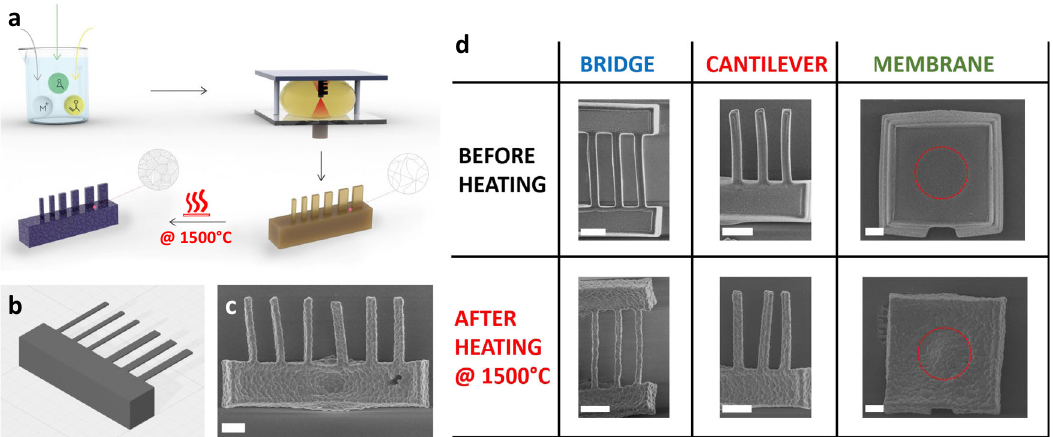
Fig. 2 Scheme of the fabrication process and images of the printed NEMS devices. a Scheme of the fabrication process starting from the precursor solution preparation, followed by TPP printing to photopolymerize locally the solution, structure washing, and fi nal heating step to remove organic content and achieve densi fi cation and crystallization. b CAD scheme and c SEM image of a chip composed of six cantilevers of two different widths. d Images of the bridge, cantilever, and membrane devices before and after the heating step at 1500 °C. All the scale bars correspond to 10